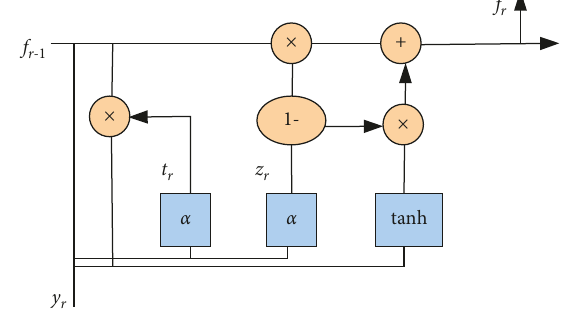
Figure 5: GRU neural network unit